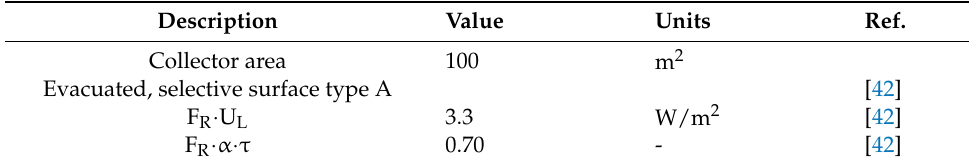
Table 2. Initial values for the modeling of the solar